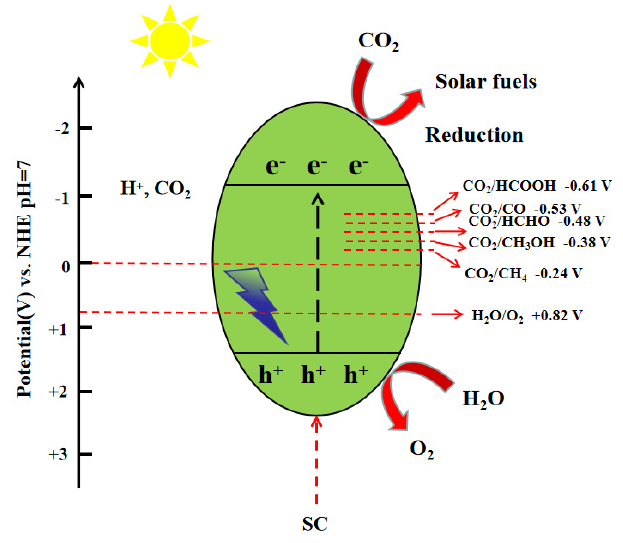
Figure 2. Mechanism of photocatalytic CO 2 reduction.